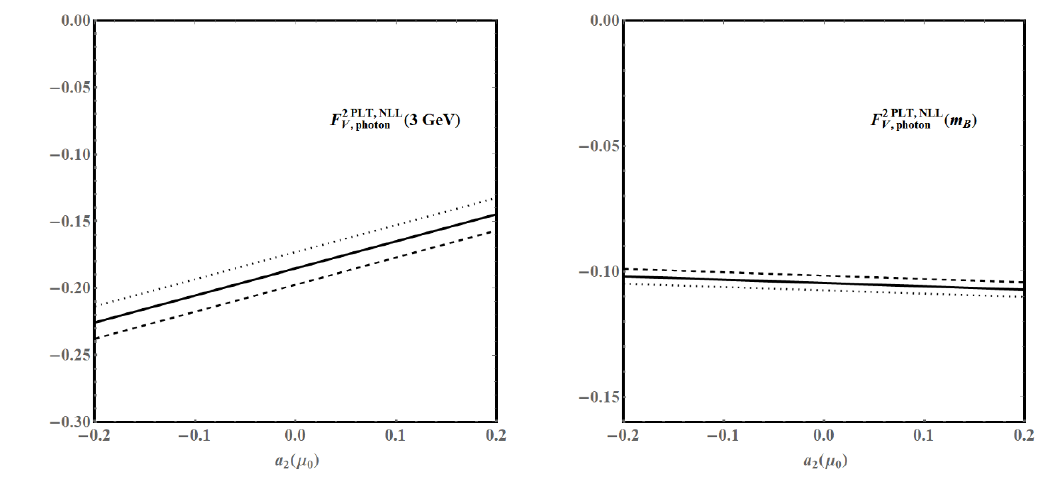
Figure 7 . Dependence of the leading-twist hadronic photon correction at n (cid:1) p = 3 GeV (left panel) and n (cid:1) p = m B (right panel) on the second Gegenbauer moment of the photon light-cone DA a 2 ( (cid:22) 0 ) with di(cid:11)erent values of the fourth Gegenbauer moment: a 4 ( (cid:22) 0 ) = 0 : 2 (dashed), a 4 ( (cid:22) 0 ) = 0 (solid) and a 4 ( (cid:22) 0 ) = (cid:0) 0 : 2 (dotted).